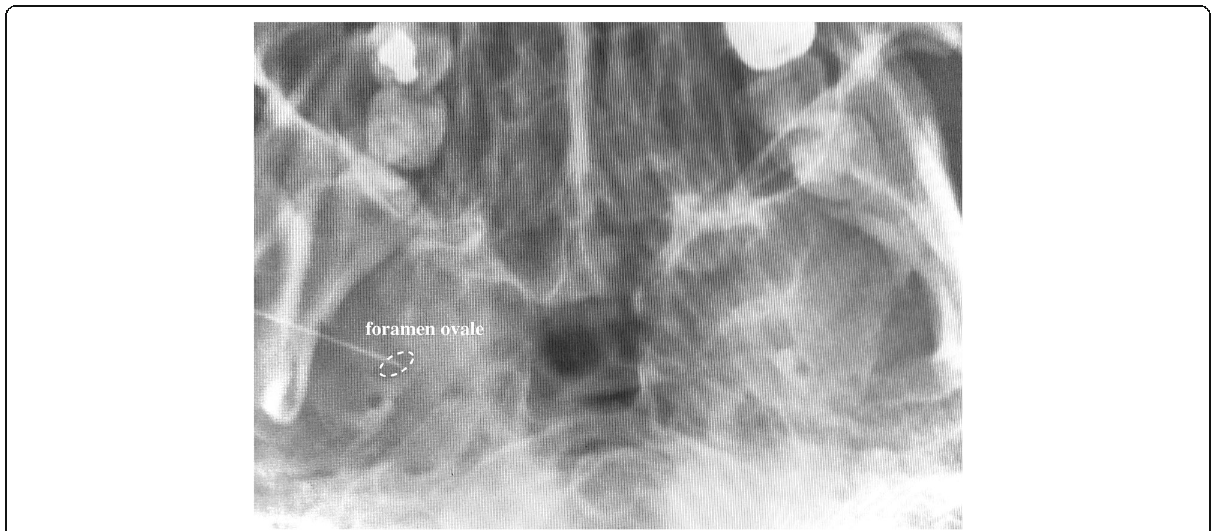
Fig. 2 Fluoroscopic image of the right mandibular nerve during radiofrequency thermocoagulation. The needle tip is overlying the foramen